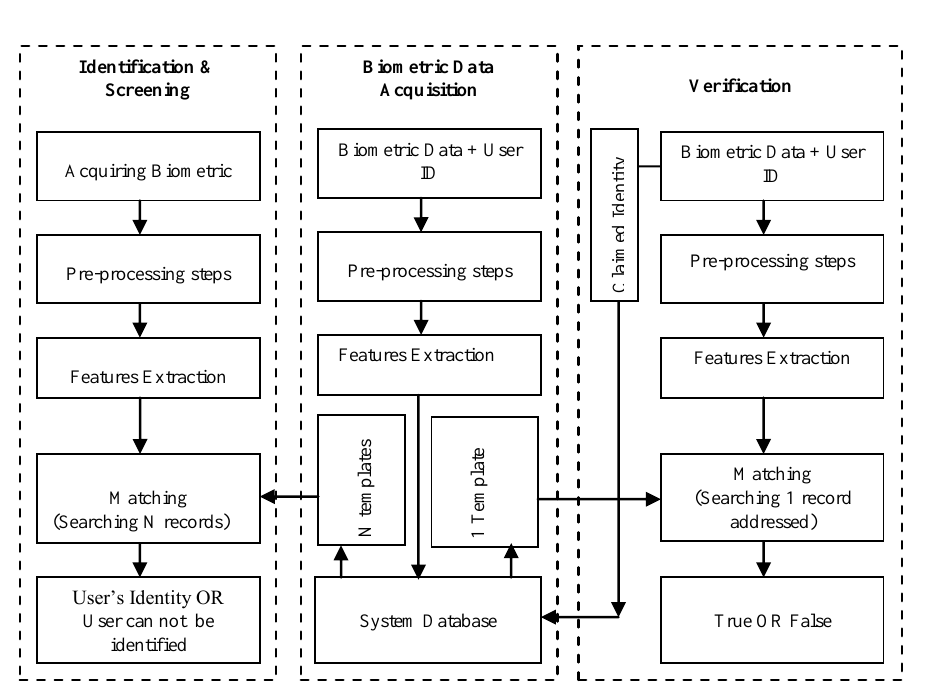
Figure 1. A typical biometric